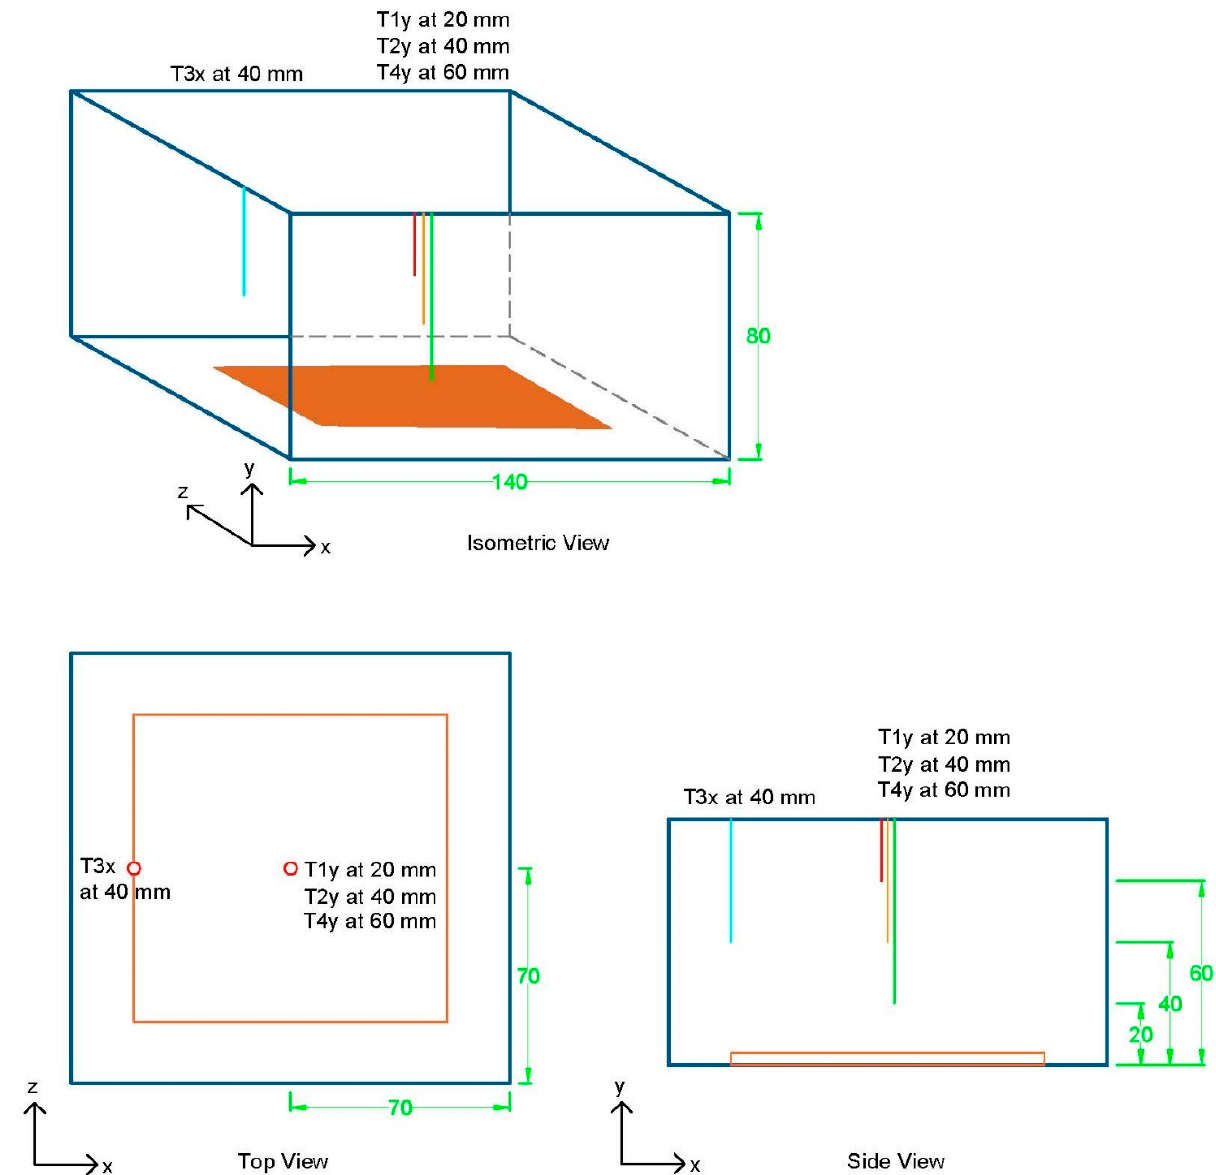
Figure 5. Schematic diagram for thermocouples positioning in a cavity.